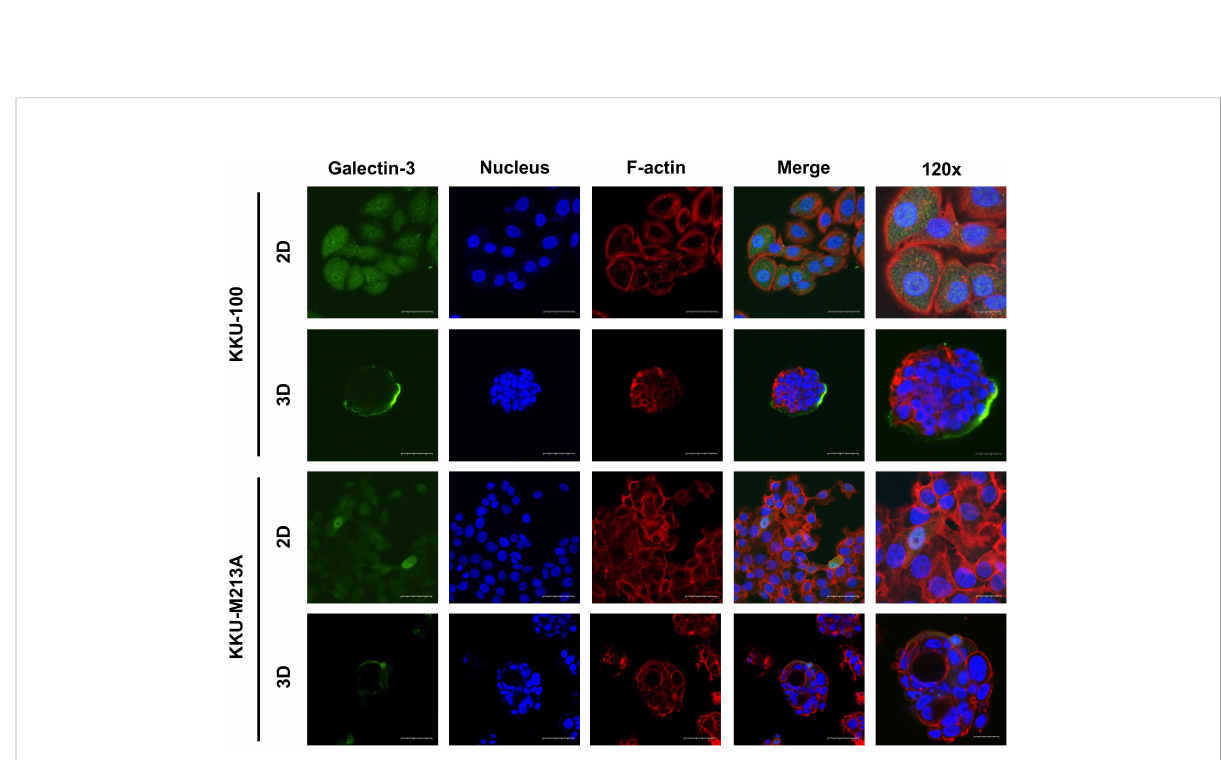
FIGURE 4 Localization of galectin-3 in 2D and 3D CCA cells. CCA cells were cultured as monolayer and spheroids for 10 days before harvesting for the immuno fl uorescence. CCA cells were fi xed, permeabilized and blocked before staining with galectin-3 antibody (green). TRITC-phalloidin and Hoechst 33342 were used as counterstains for F-actin (red) and nuclei (blue), respectively. The tumor spheroid images were taken under a confocal microscope using 60x and 120x magni fi cations. The scale bars in 2D and 3D systems indicate 25 µm and 10 µm,